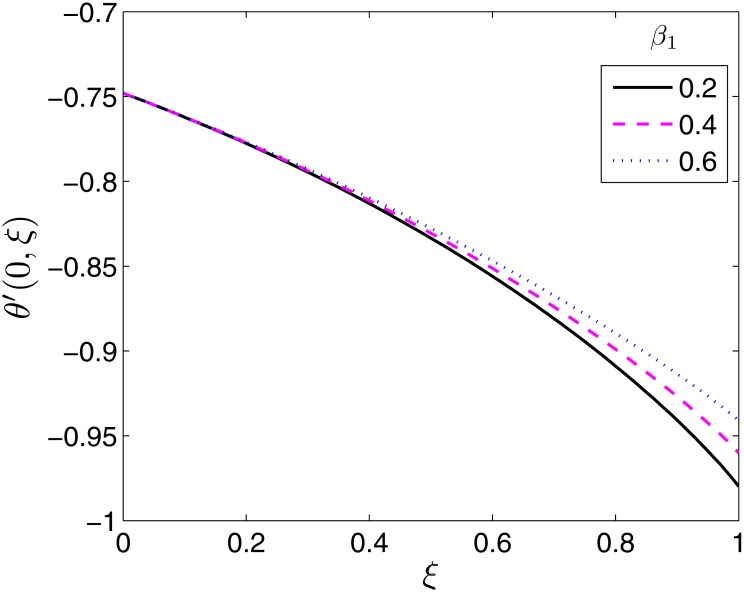
Effect of β
1 on θ′(0, ξ).
β = 0.5, β
2 = 1ϵ = 0.4, Pr = 2, S = 0.2.